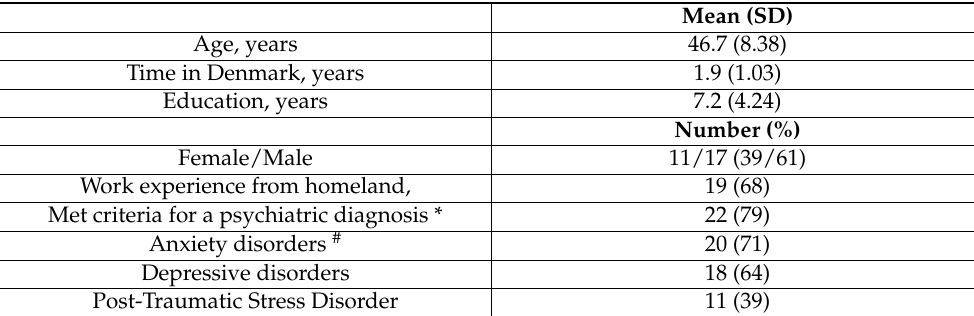
Table 2. Demographic and clinical characteristics of groups 1 and 2 (n =